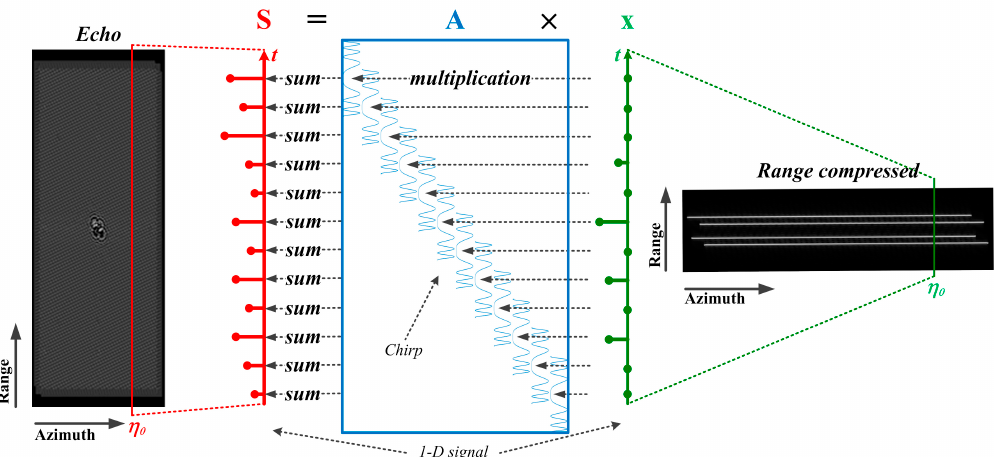
Figure 11. The relationship between S and x . There are four point targets at the center of the scene, the echo of which spreads over a wide area, and the range compressed result is four lines. After range migration correction and azimuth compression, we can obtain the focused data. The MAP version of (12) is as follows.